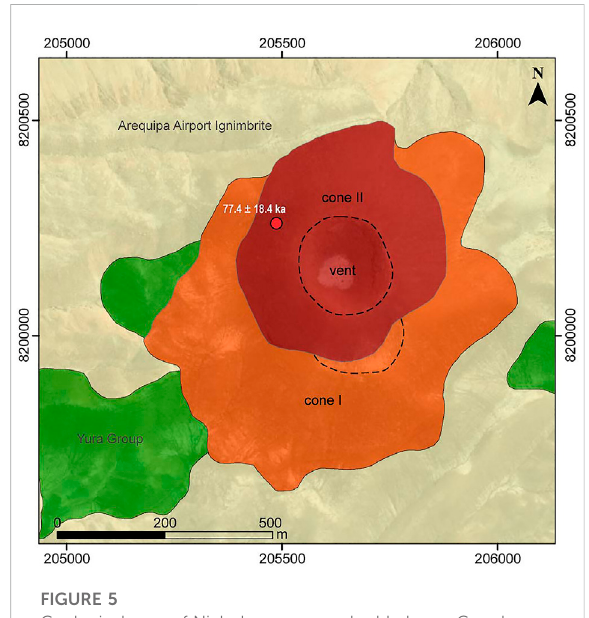
FIGURE 5 Geological map of Nicholson cone embedded on a Google Earth